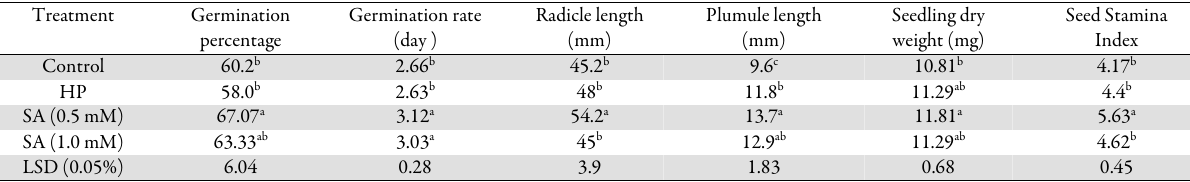
Tab. 2. Mean comparisons of effect of salinity on milk thistle seed germination behaviors Treatment